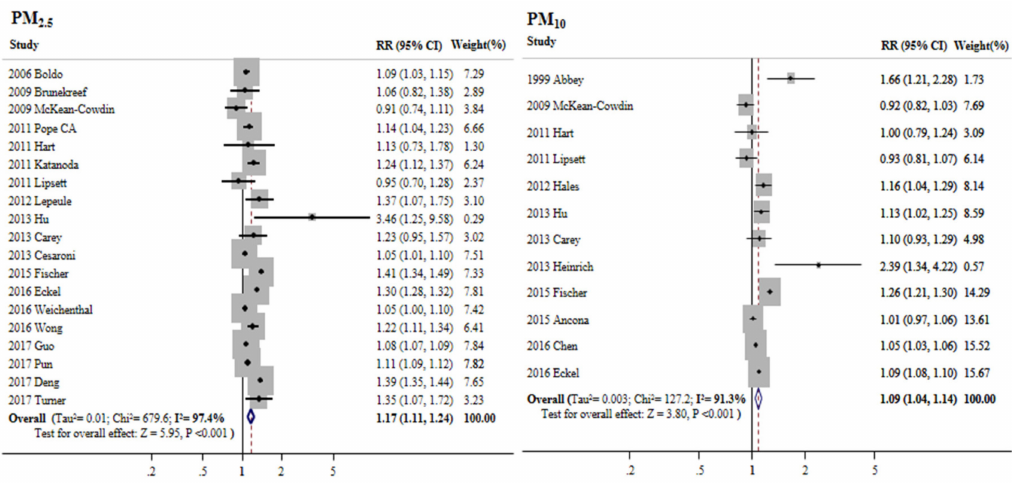
Figure 2. Mortality from cancer according to long-term exposure to particulate matter (PM) in a random-effects meta-analysis of observational studies. RR, relative risk; CI, confidence interval (RR and 95% CI are for a 10 µ g/m 3 increase in PM 2.5 and PM 10